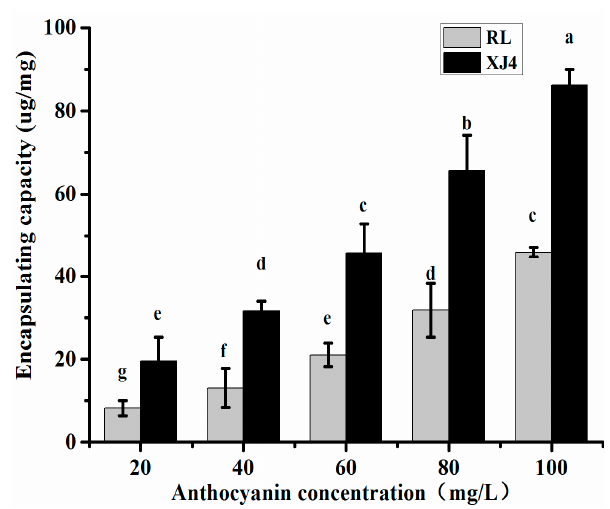
Figure 2. Encapsulating capacity of Corn Starch Nanoparticles (CSNPs) under different anthocyanin concentrations. Within samples, different letters (a–g) mean significant differences ( p < 0.05).